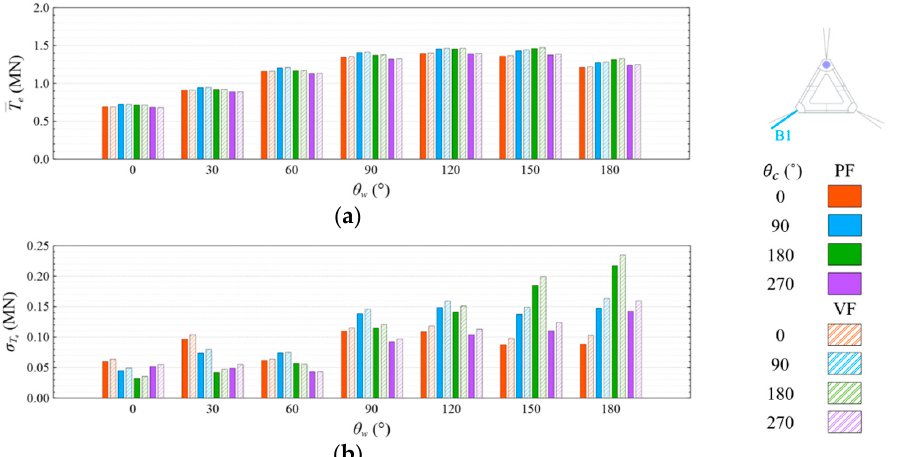
Figure 36. Comparison of ( a ) means and ( b ) standard deviations of mooring line tension of Line B1 under HW condition.